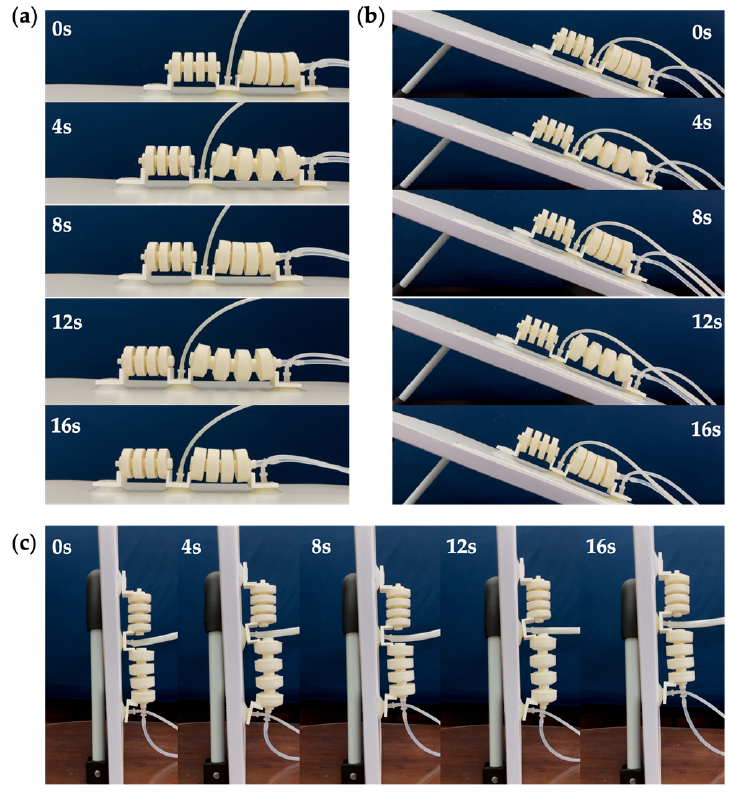
Figure 21. Straight-line locomotion testing. ( a ) On the flat ground. ( b ) On the slope. ( c ) On the vertical wall.